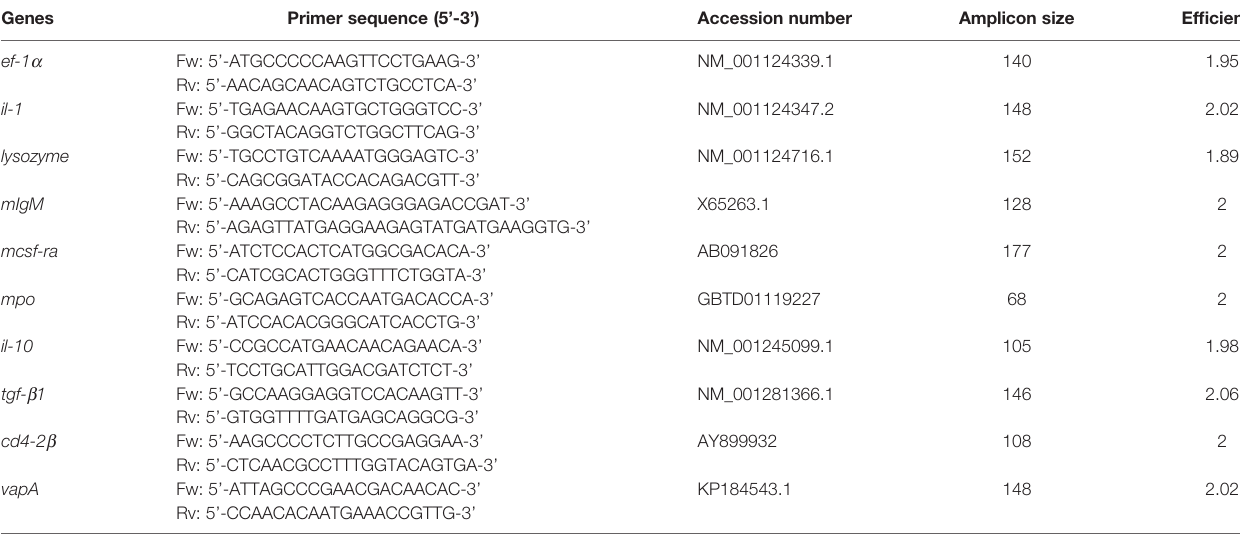
TABLE 2 | Primers used for each gene expression analysis by real-time